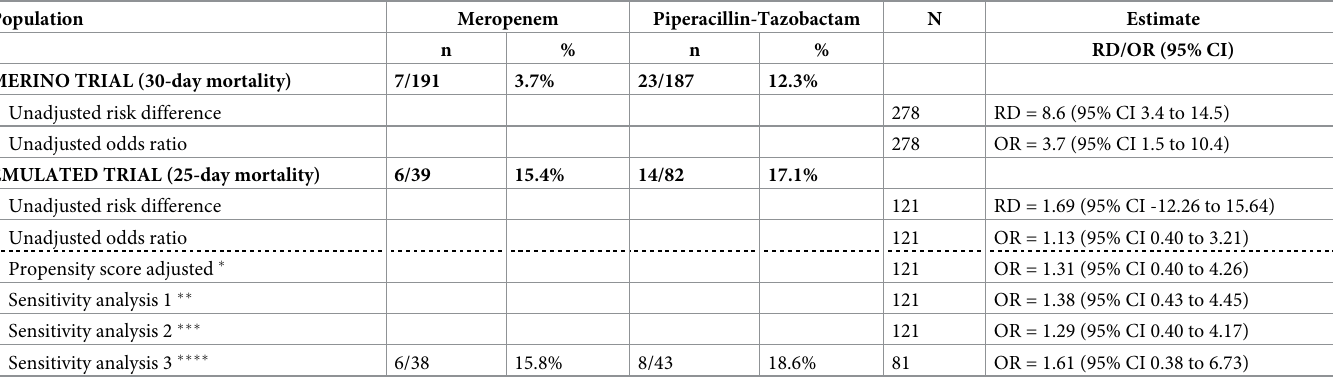
Table 3. Primary analysis: 25-day